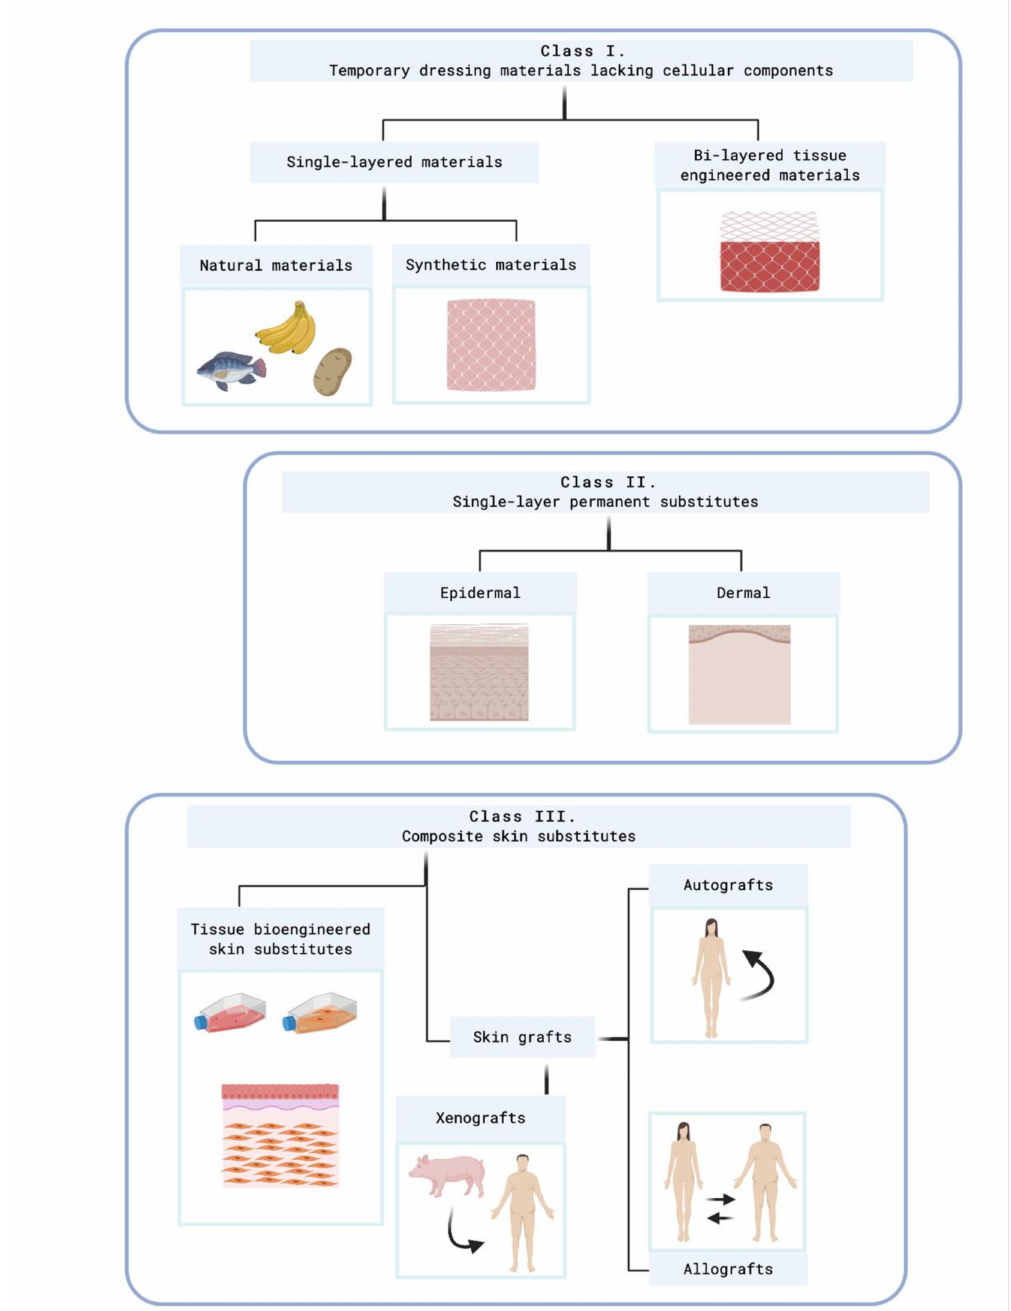
Figure 3. Kumar’s classification system. Created with BioRender.com. At class II, subclass epidermal, Kumar includes cultured epidermal autografts (CEA) and Apligraf ® , which are cellular skin substitutes. At class II, subclass epidermal, acelular skin substitutes which are made of extracellular matrix (ECM) compounds are included as PermacolTM ® , Matriderm ® , Alloderm ® , or Kollagen ® . However, it is necessary to highlight that a standard classification system does not exist. The parameters showed above have similar importance so, finally, each author could classify the skin equivalents under its